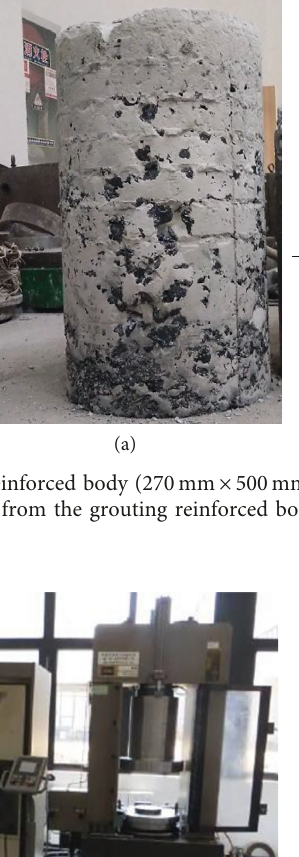
Figure 5: MTS 815 rock mechanical test system.